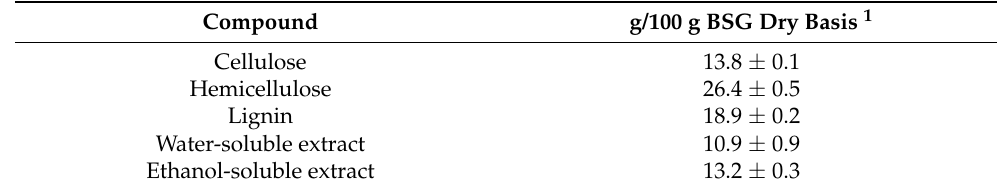
Table 2. Structural carbohydrates of brewers’ spent grain without treatment (BSG) and water and ethanol